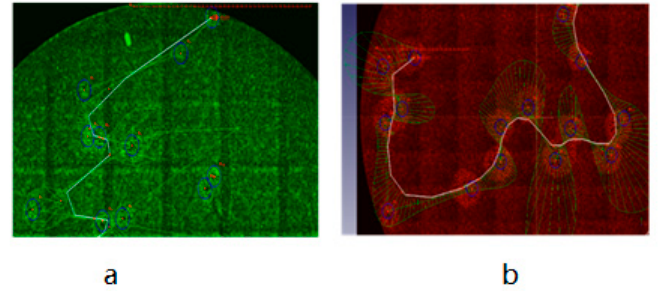
Figure 8. Wild-type viral plaques counted through FreeCAD software ( a , b ). ( a ) Viral plaque counting with LIVP1.1.1-infected CV-1-pTet-TurboFP635-EF-1a-Egfp cell line through the FreeCAD software. ( b ) Viral plaque counting with LIVP1.1.1-infected CV-1-EF-1a-TurboFP635 cell line through the FreeCAD software.